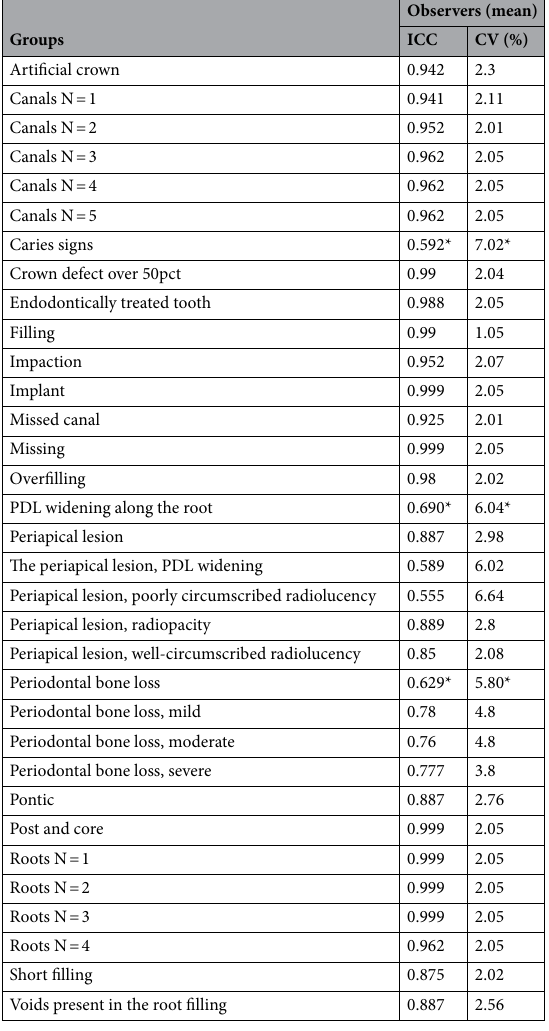
Table 1. Inter-observer agreement among observers according to evaluated variables. CV, coefficient of variation; ICC, intraclass correlation coefficient. *Indicates significant difference p-value less than 0.05.